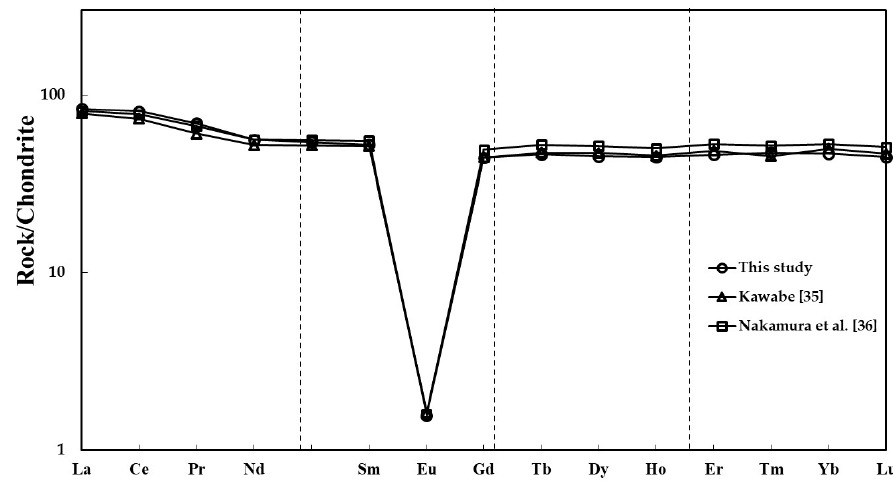
Figure 3. Chondrite-normalized REE pattern of JG2 to compare new data from this study with published values [35,36]. Normalizing chondrite values are taken from McDonough and Sun [37].